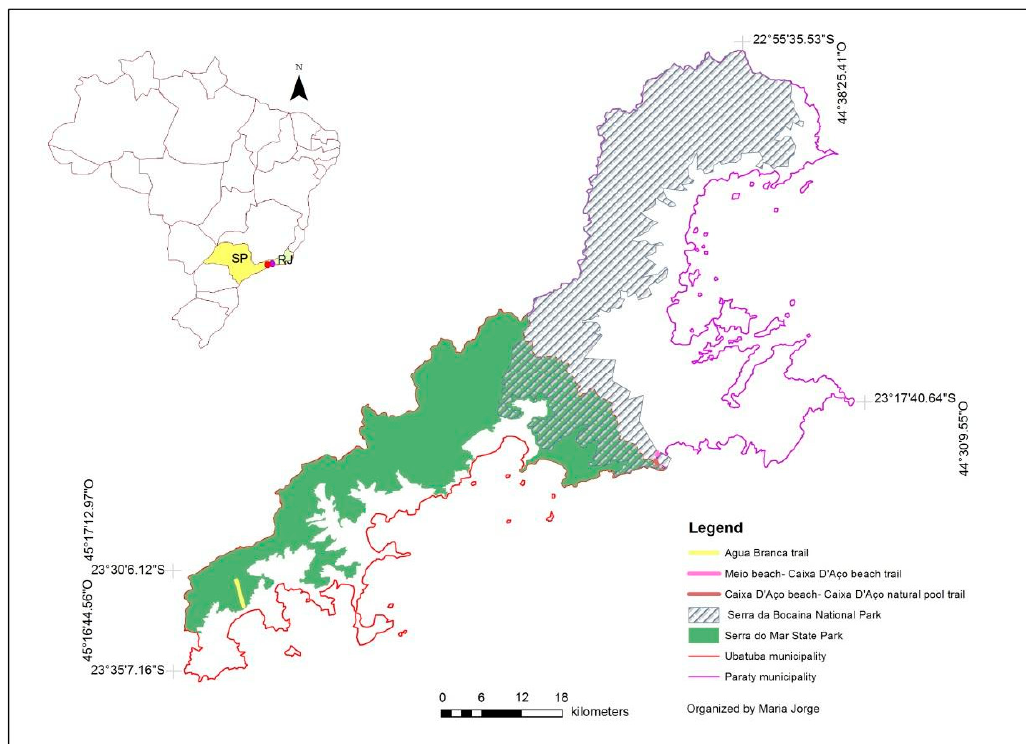
Figure 1. Study area. Organized by Maria Jorge.